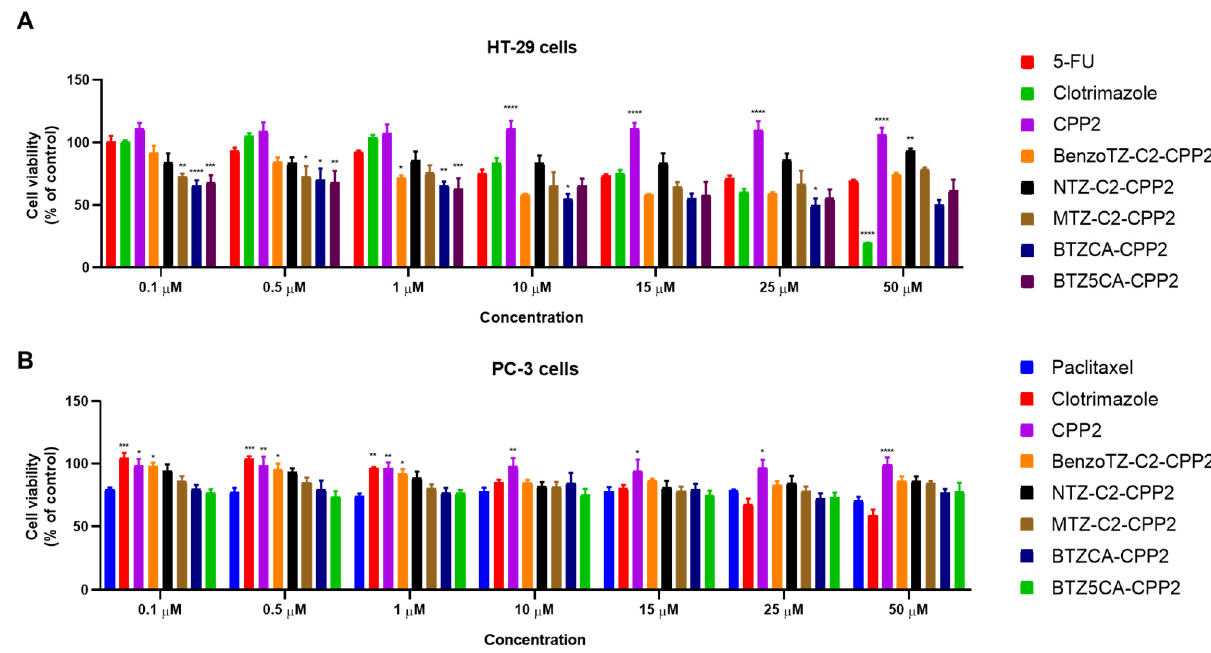
Figure 2. Cytotoxic effects of 5-FU or PTX, CLZ, CPP2 and CPP2–thiazole conjugates on the viability of HT-29 ( A ) and PC-3 ( B ) cells, respectively. Cell viability was assessed by MTT assay after 48 h of exposure to each treatment. The results are expressed in the percentage of cell viability relative to untreated control cells. *, **, *** and **** indicate p < 0.05, p < 0.01, p < 0.001 and p < 0.0001, respectively, when compared with 5-FU or PTX. All data are presented as the mean ± SEM of three independent experiments.